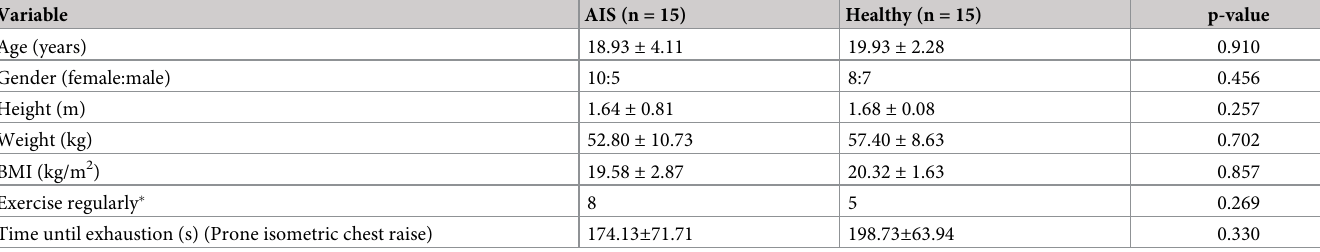
Table 1. Descriptive statistics for the participants (mean ±